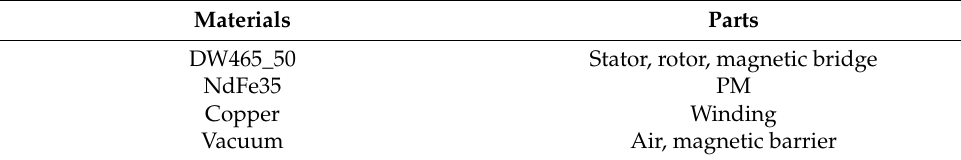
Table 2. The materials for the